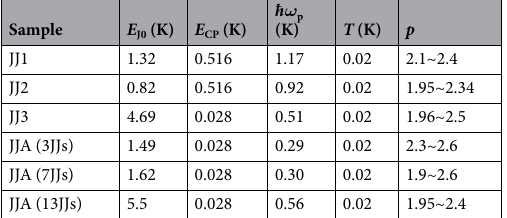
Table 1. Parameters and fitted p values for various samples, including single junctions and junction arrays. The superconducting gap Δ of our samples are all about 250 μ V (2.9